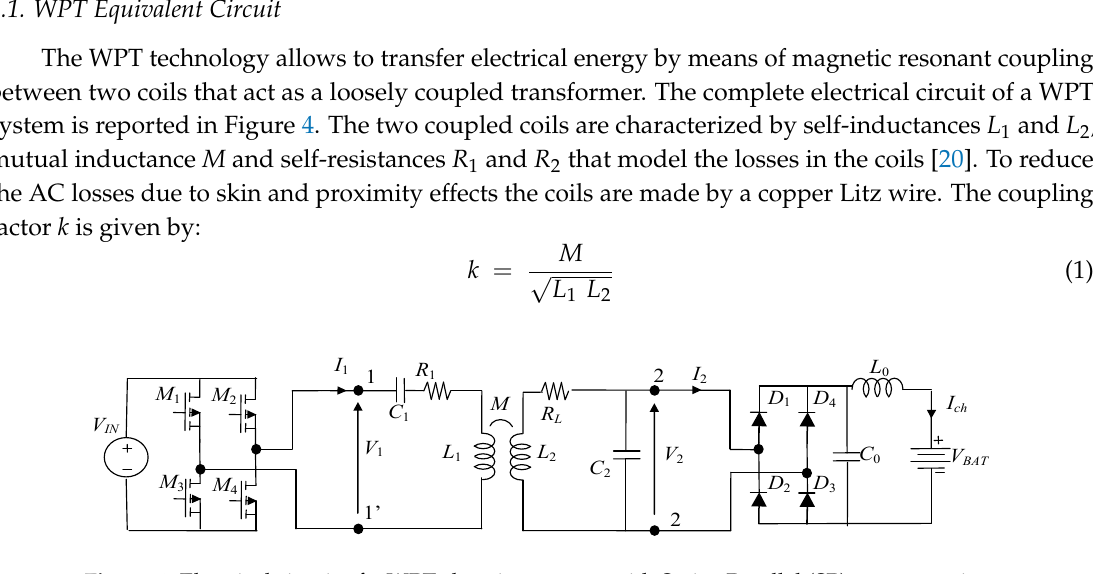
Figure 3. Adopted electrical configuration of the WPT charging for a drone.